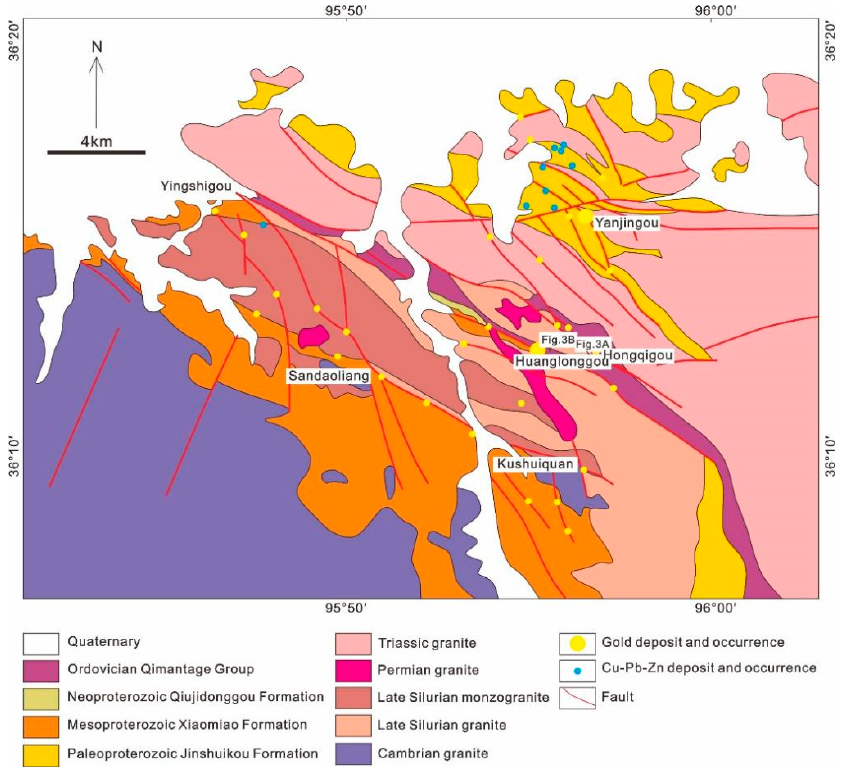
Figure 2. Geological map of the Wulonggou Gold Field (modified after [9]).